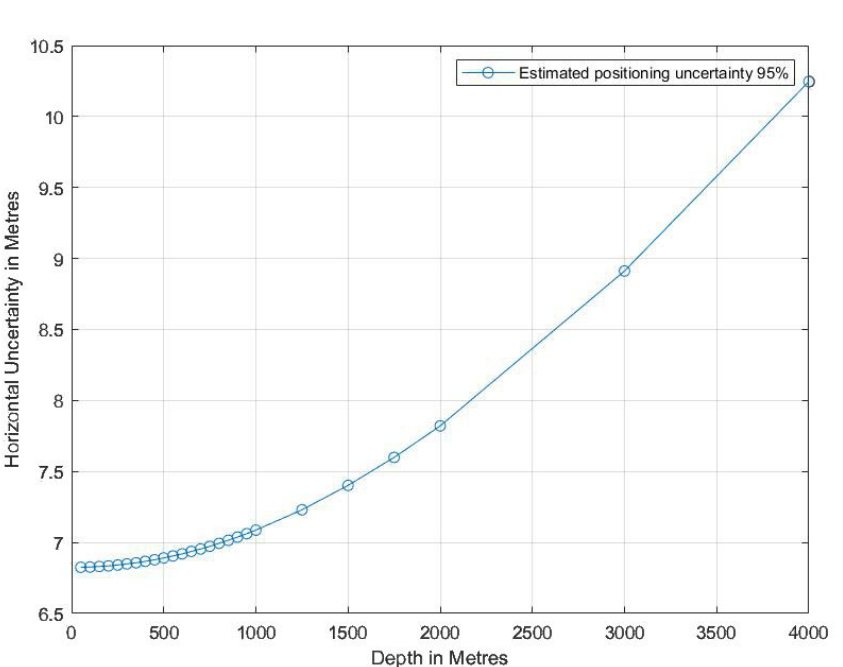
Figure 19. The total combined positioning uncertainty excluding the AINS uncertainty, 2 σ , assuming an XY Vessel AUV relationship of 50 m.